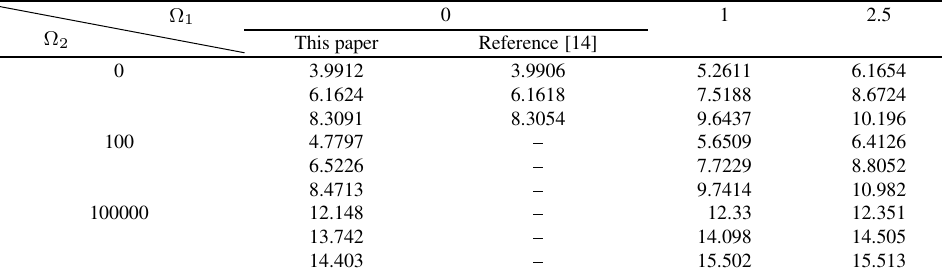
Table 7 Dimensionless natural frequencies of one stepped beam on Pasternak soil with clamped-clamped boundary condition Ω 1 0 1 2.5 Ω 2 This